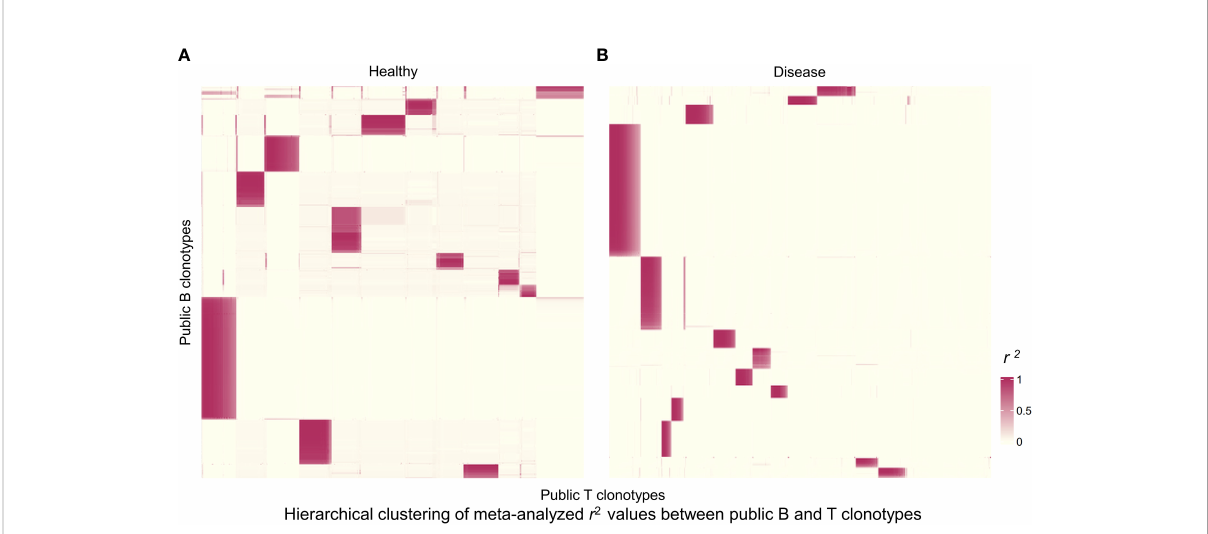
FIGURE 4 Hierarchically clustered heatmap of correlations between public B and T cell clonotype proportions. (A) Heatmap for public clonotypes from healthy individuals. Heatmap displays r 2 values for 1,244 B cell clonotypes and 4,084 T cell clonotypes. Each rectangle represents a cluster of B and T cell clonotypes analyzed for sequence motifs and amino acid physical properties. (B) Heatmap for public clonotypes from individuals with disease. Heatmap displays r 2 values for 859 B cell clonotypes and 4,459 T cell